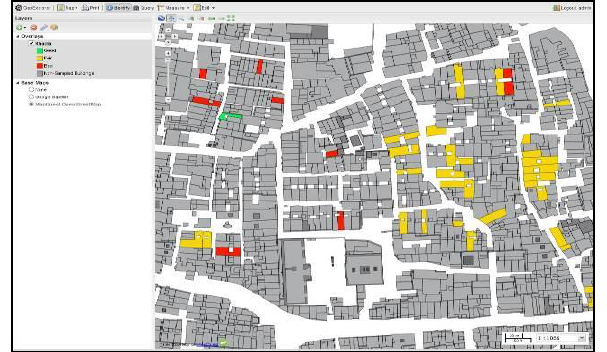
Figure 8. Search highlighting the condition of the buildings